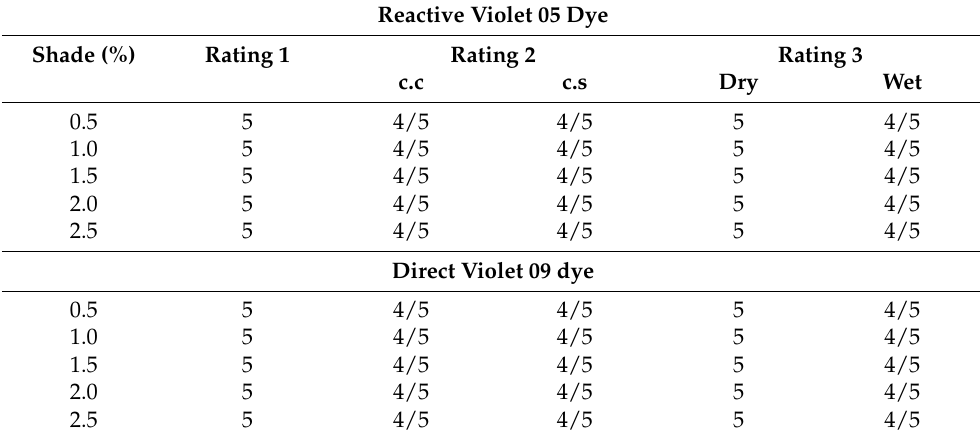
Table 6. Rating of fastness properties of fabric dyed at optimal conditions using RV5 and DV 9